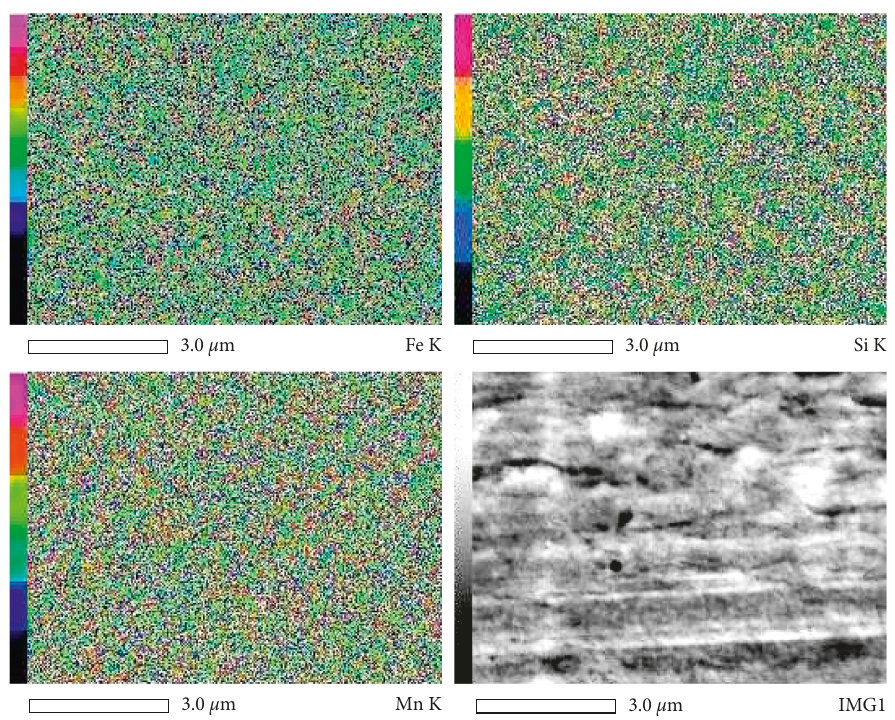
Figure 5: SEM and EDX analysis of Fe-30Mn-6Si bulk alloy after MA, sintering, and annealing.